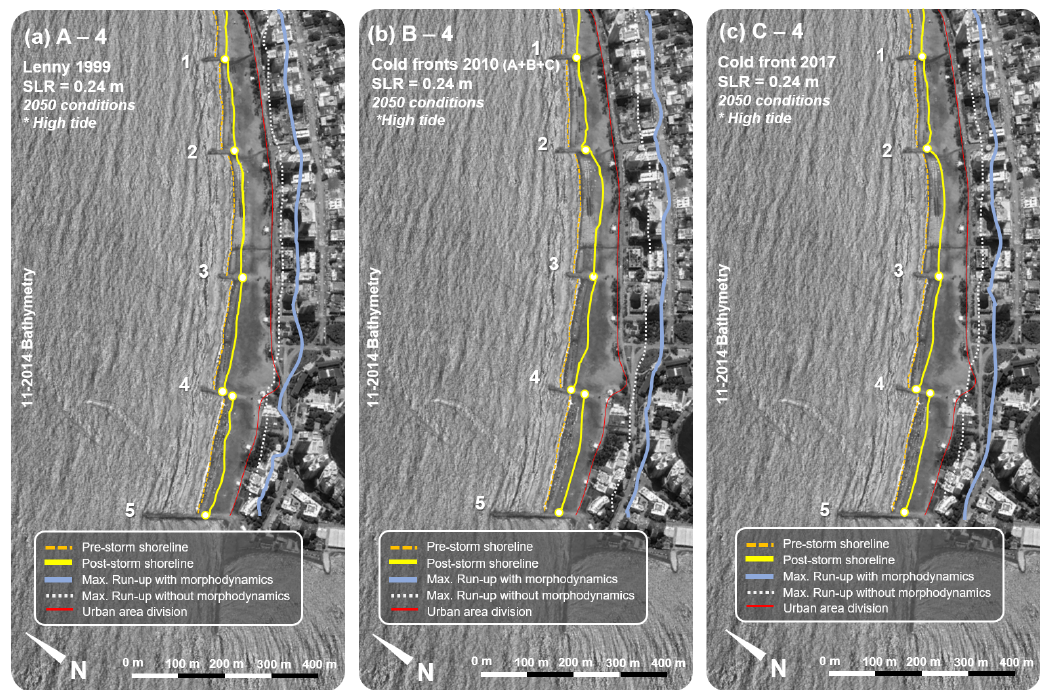
Figure 6. Maximum flood range (with and without morphodynamics) and post-storm shorelines simulated by XBeach including additional effect of a + 0 . 25m high tide for Lenny 1999 (a) , 2010 cold front succession (b) , and 2017 cold front (c) with different SLR conditions. Map base images retrieved from © Google Earth and modified by the authors.